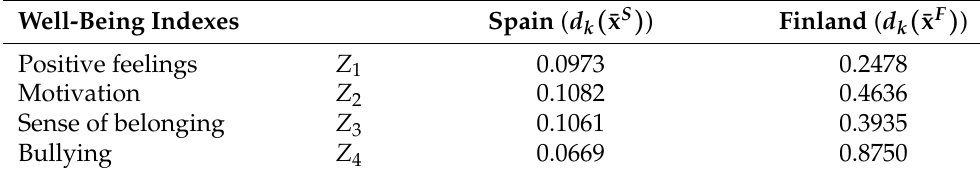
Table 10. Distances of the interval objective values of the solutions ¯ x S and ¯ x F to their interval ideal